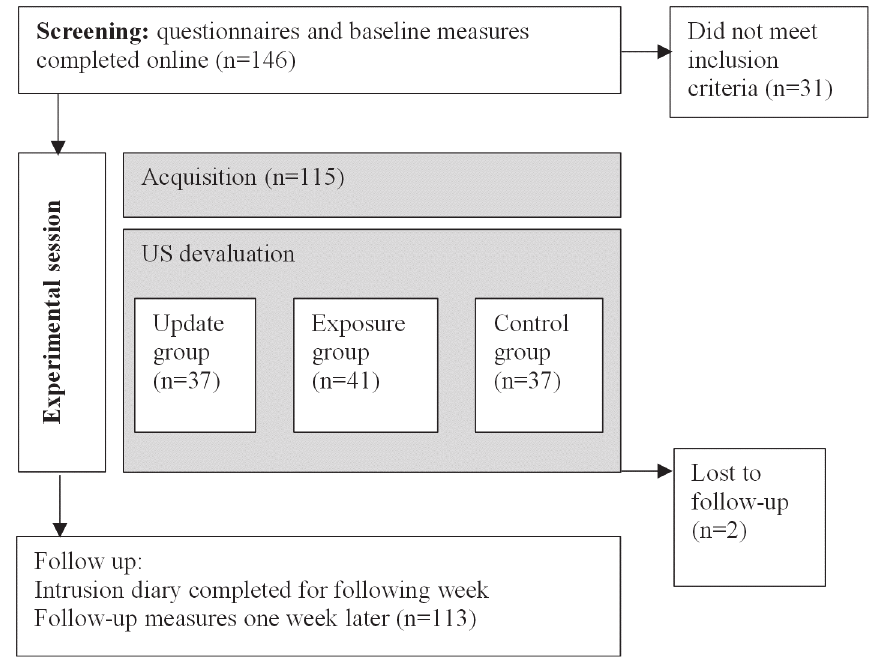
Fig 1. Summary of